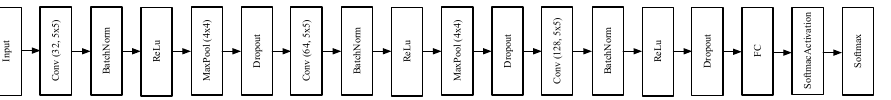
Figure 3. Designed CNN architecture trained from scratch: ( c , a × b ) means c filters with the size of a × b